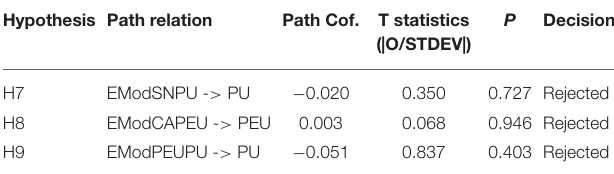
TABLE 15 | Moderation assessments of